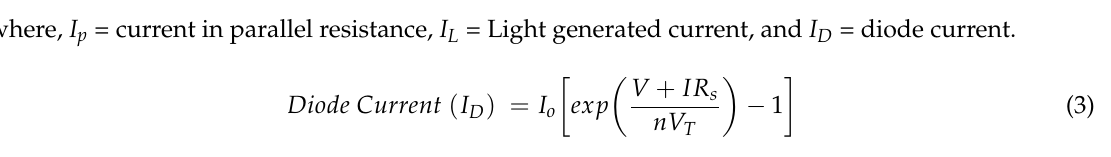
Figure 2. Block diagram of solar energy harvesting system using PWM and MPPT control. ( a ) Using PWM control; ( b ) using MPPT